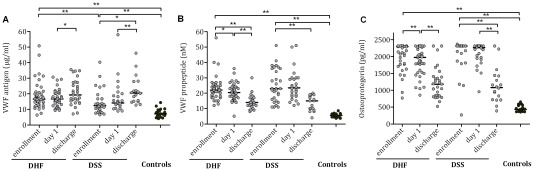
Plasma levels of Weibel-Palade body constituents in Indonesian children with dengue.(A) VWF antigen, (B) VWF propeptide and (C) osteoprotegerin levels (all determined by ELISA) in Indonesian children with dengue hemorrhagic fever (DHF) and dengue shock syndrome (DSS) and in healthy controls. Horizontal lines represent median values. The upper limit of detection of the OPG assay was 1200 pg/ml; 49% and 70% of children in the DHF and DSS group, respectively, had an OPG plasma level above this cut-off value at enrollment. No plasma available for analysis in two patients from the DHF group and one from the DSS group at day 1 and in fifteen and six patients from the DHF and DSS group at discharge. P values were determined by Wilcoxon matched-pairs signed rank test for data in time and Mann Whitney U- test for comparison with the control group. *p value<0.05, **p value<0.01.